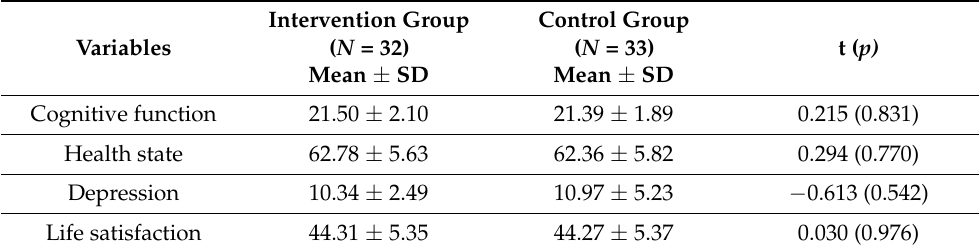
Table 3. Homogeneity in study variables before experimental intervention.